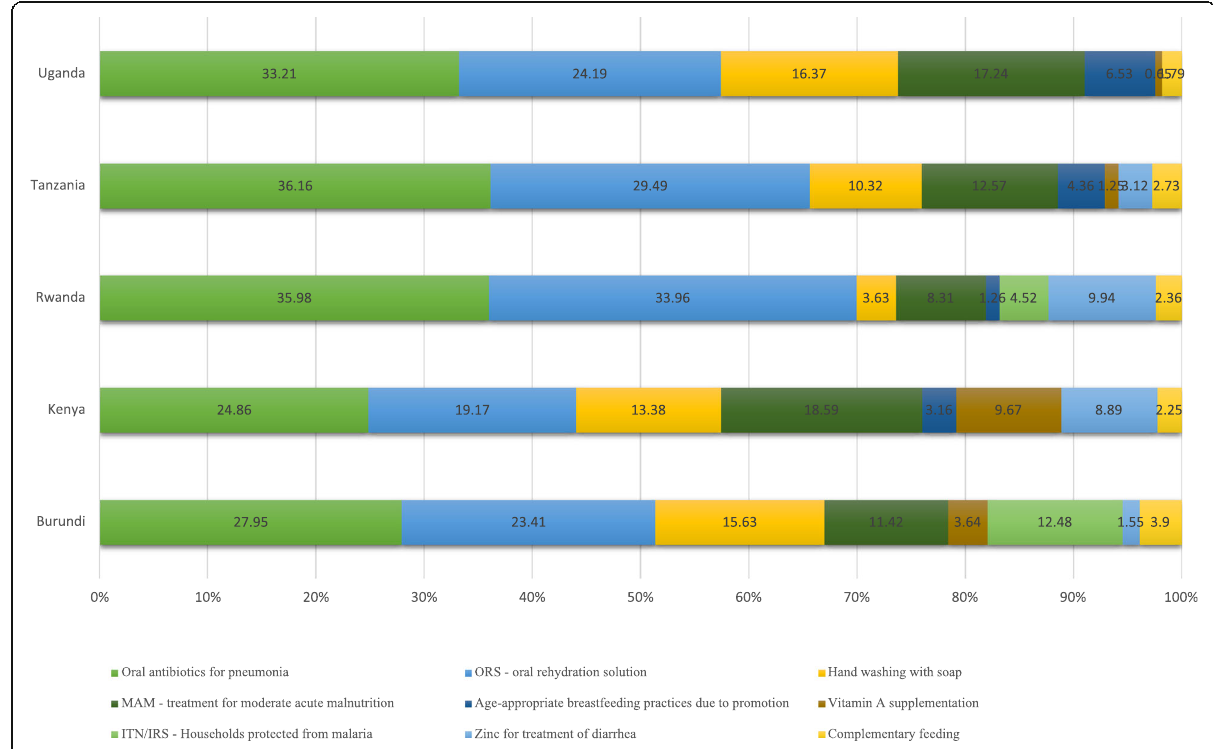
Fig. 4 Percent of deaths averted by 2030 by intervention under ideal coverage scenario relative to business as usual coverage